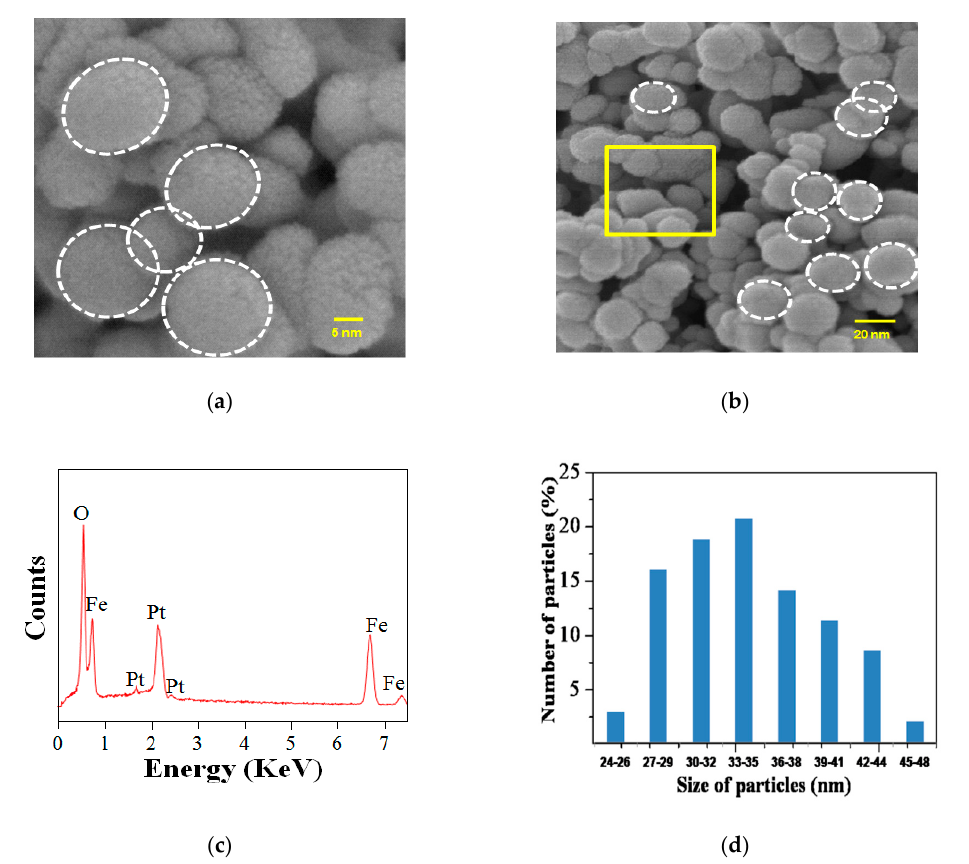
Figure 4. ( a ) Field emission scanning electron microscopy (FESEM) micrograph of the Sp-HNP at 20,000 × magnification (the dotted circle suggesting a spherical structure); ( b ) FESEM micrograph of the Sp-HNP at 5000 × magnification (with corresponding selected-area electron diffraction (SAED)); ( c ) energy dispersive X-ray spectroscopy (EDX) analysis spectra on SAED; and ( d ) histograms showing the particle size distributions.